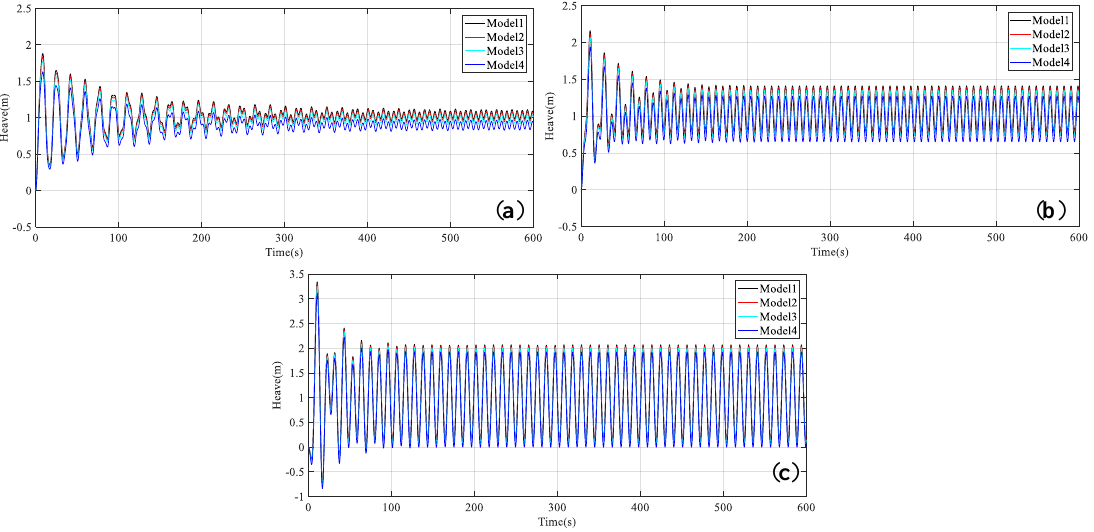
Figure 9. Time domain curves of the heave motion of Models 1~4: ( a ) LC1; ( b ) LC2; and ( c ) LC3.